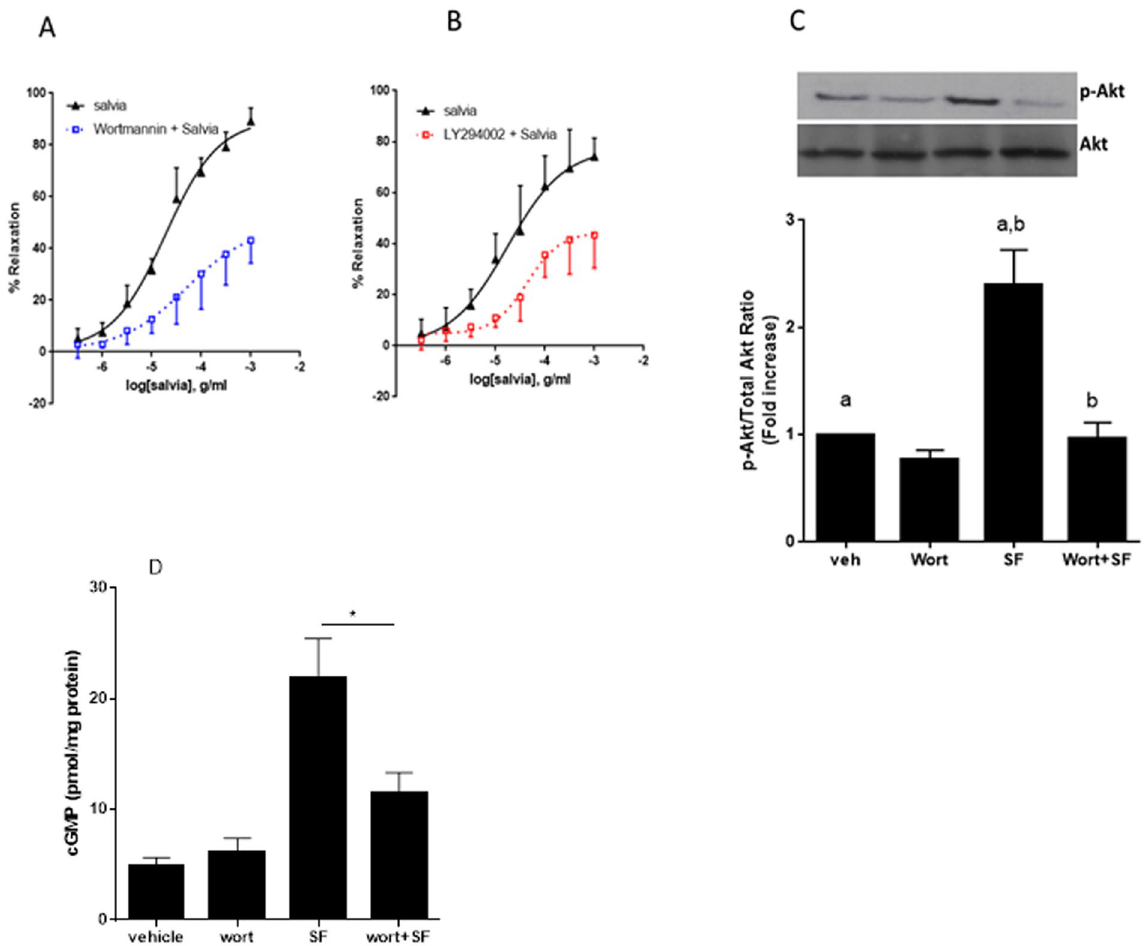
LY29400 (10 µ M; squares). Data represent mean ± SEM (n = 5; p < 0.01 for Salvia versus Wortmannin + Salvia or LY29400 + Salvia). ( C ) Modulation of Akt phosphorylation by SF. Aortic rings were incubated in either the absence (veh) or presence of wortmannin (wort) for 30 minutes. Rings were then pre-contracted with NE (3 µ M) followed by treatment with SF (0.67 mg/ml) for 15 minutes. Proteins were extracted and subjected to SDS-PAGE against phosphorylated and total Akt levels. Bar graph represents normalization of the phosphorylated Akt levels to total ones. Bars with similar letters are significantly different; p < 0.05); n = 4 rings. ( D ) Rings were incubated with or without SF (0.67 mg/ml) after having been pre-treated without (vehicle) or with wortmannin (wort; 0.1 µ M) for 30 minutes. Then, cGMP levels were determined. n = 5; * denotes a p <